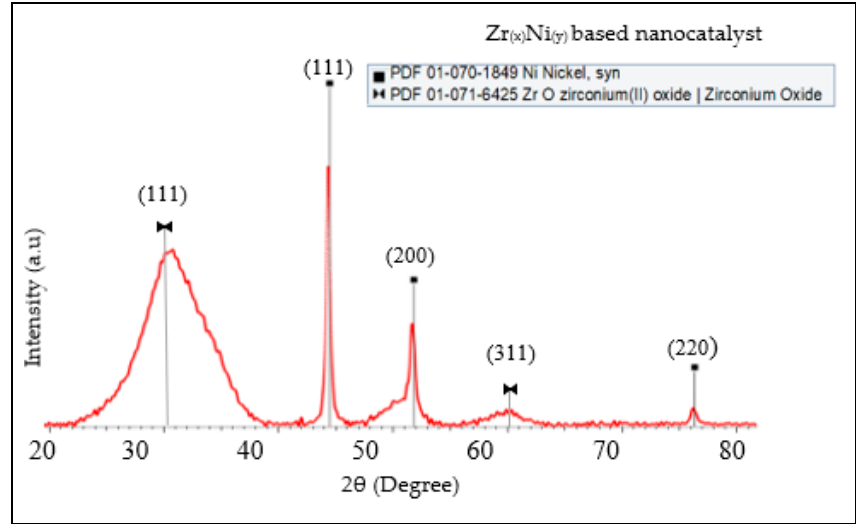
Figure 1. The XRD patterns of Zr (x) Ni (y) based nanocatalyst.